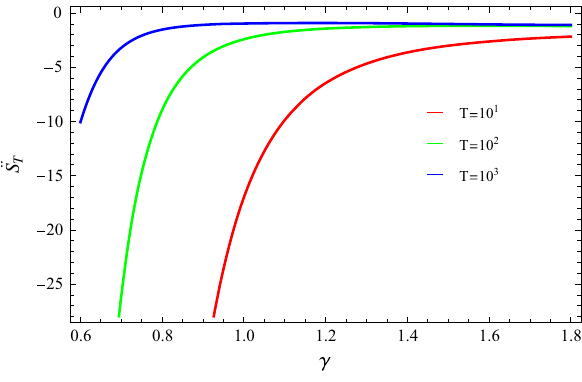
¨ S T and γ for three ¨ S T corresponding to